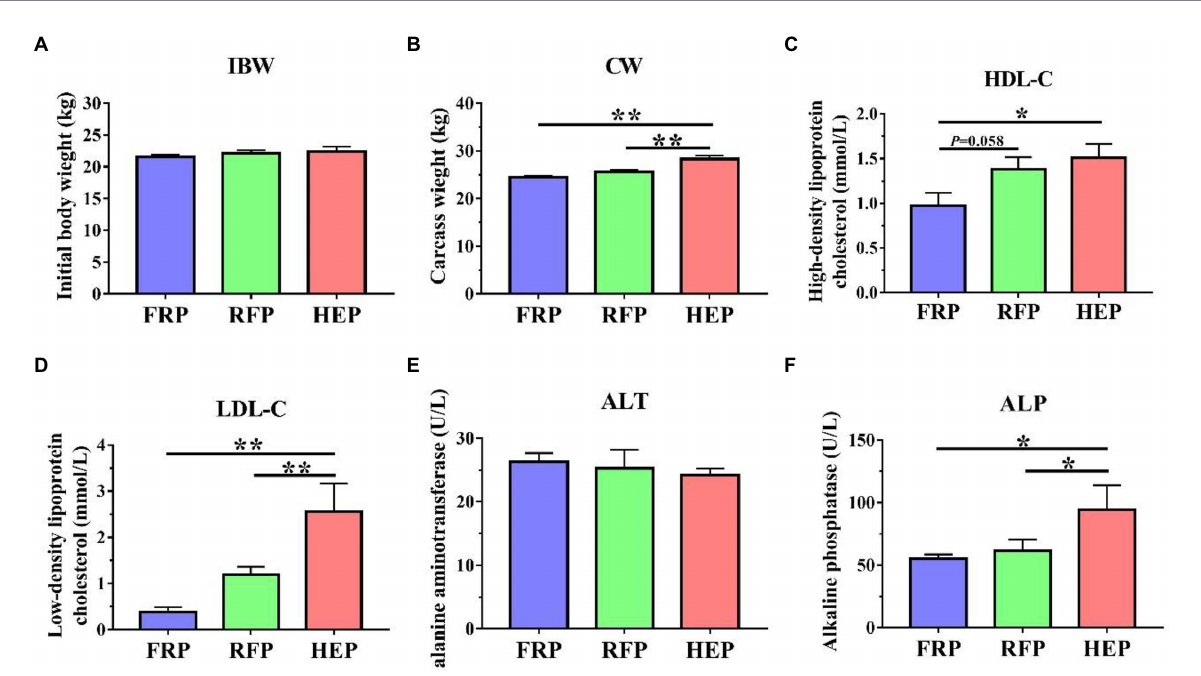
FIGURE 1 Effects of different feeding patterns on the CW, and HDL-C, LDL-C, ALT ALP in serum of Tibetan pigs. (A) The initial body weight (IBW) of Tibetan pigs. (B) The carcass weight (CW) of Tibetan pigs. (C) The content of high-density lipoprotein cholesterol (HDL-C) in serum of Tibetan pigs. (D) The content of low-density lipoprotein cholesterol (LDL-C) in serum of Tibetan pigs. (E) The activity of alanine aminotransferase (ALT) in serum of Tibetan pigs. (F) The activity of alkaline phosphatase (ALP) in serum of Tibetan pigs. Data are expressed as mean ± SE ( n = 6–7). * and ** indicates p < 0.05 and p < 0.01, respectively. FRP: free-ranging Tibetan pigs; RFP: feeding the regular Tibetan pig diets; HEP: feeding the high energy content diets.